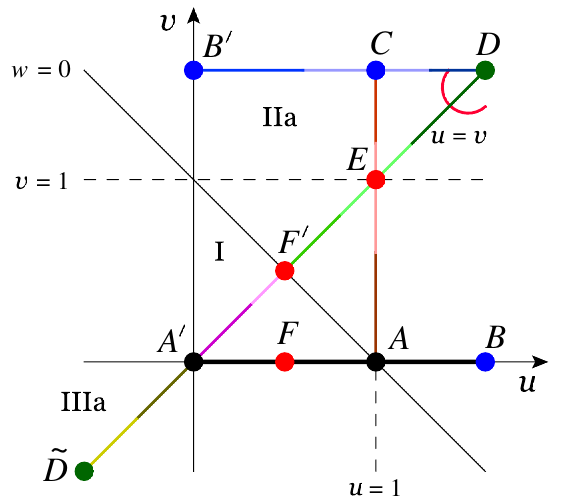
Figure 2. Various lines in the ( u, v ) plane along which the form factor can be expressed in terms of HPLs. On the black and blue lines, the HPLs have indices { 0 , 1 } ; on the other lines the indices are {− 1 , 0 , 1 } . Values at the black and blue points are all MZVs. At the red points they are alternating sums, and at the green points they could be either, depending on the direction of approach. See the text for further